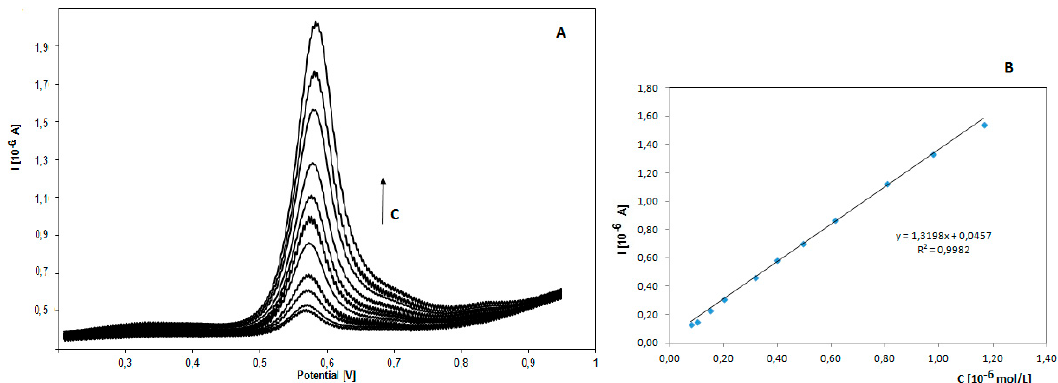
Figure 6. Square wave voltammetry (SWV) voltammograms of different concentrations of itraconazole in B-R buffer pH 2.87 (range of concentration 7.9 × 10 − 8 to 1.2 × 10 − 6 mol·L − 1 ) ( A ); Calibration curves of itraconazole using SWV methods, on the boron-doped diamond (BDD) electrode ( B ).